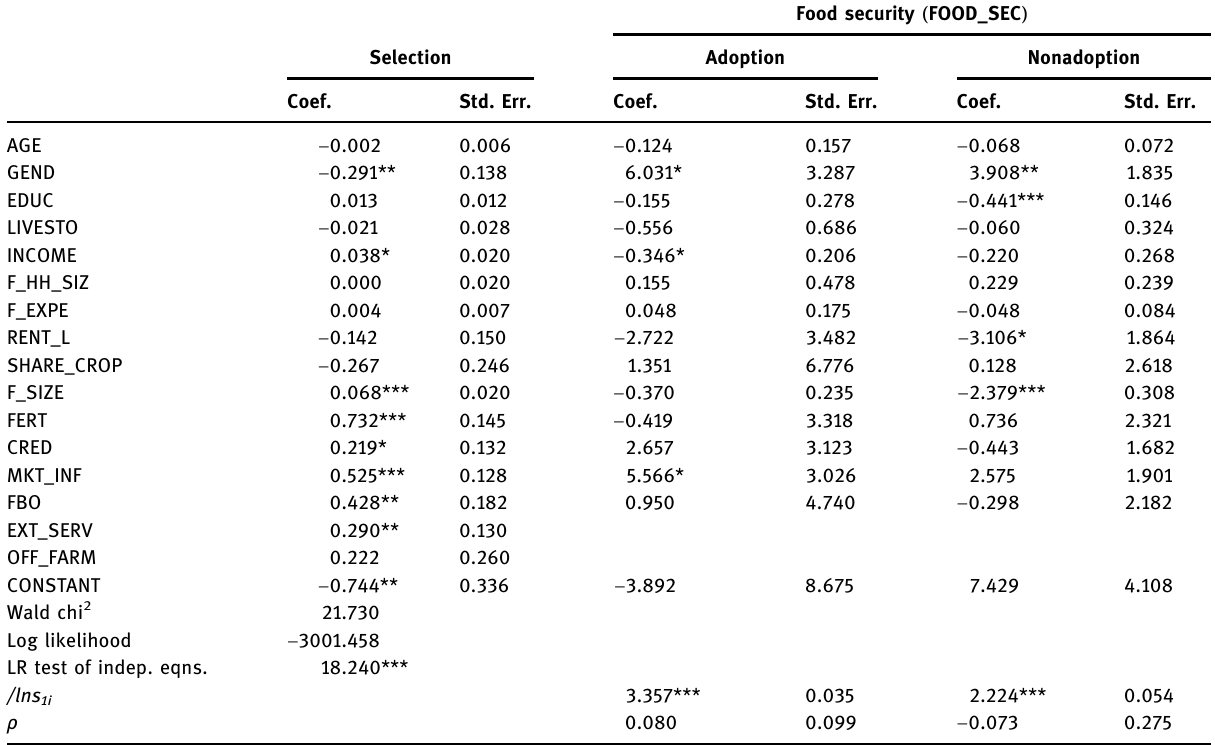
Table 4: Endogenous switching regression estimates for the determinants of improved rice variety adoption and food